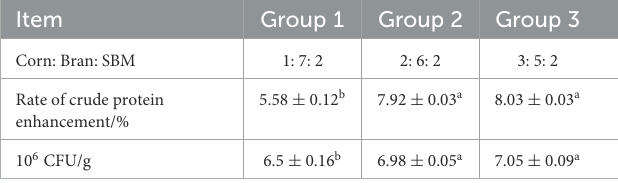
TABLE 3 Effect of fermentation substrates ( n =